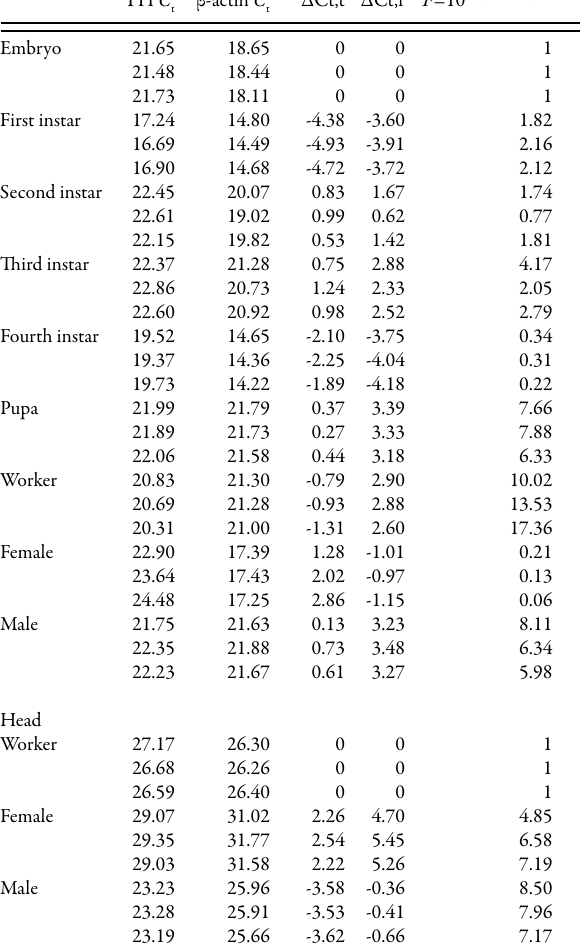
table 3. PvtH expression levels calculated for three replicates based on the formula F =10 Δct,t/At-Δct,r/Ar